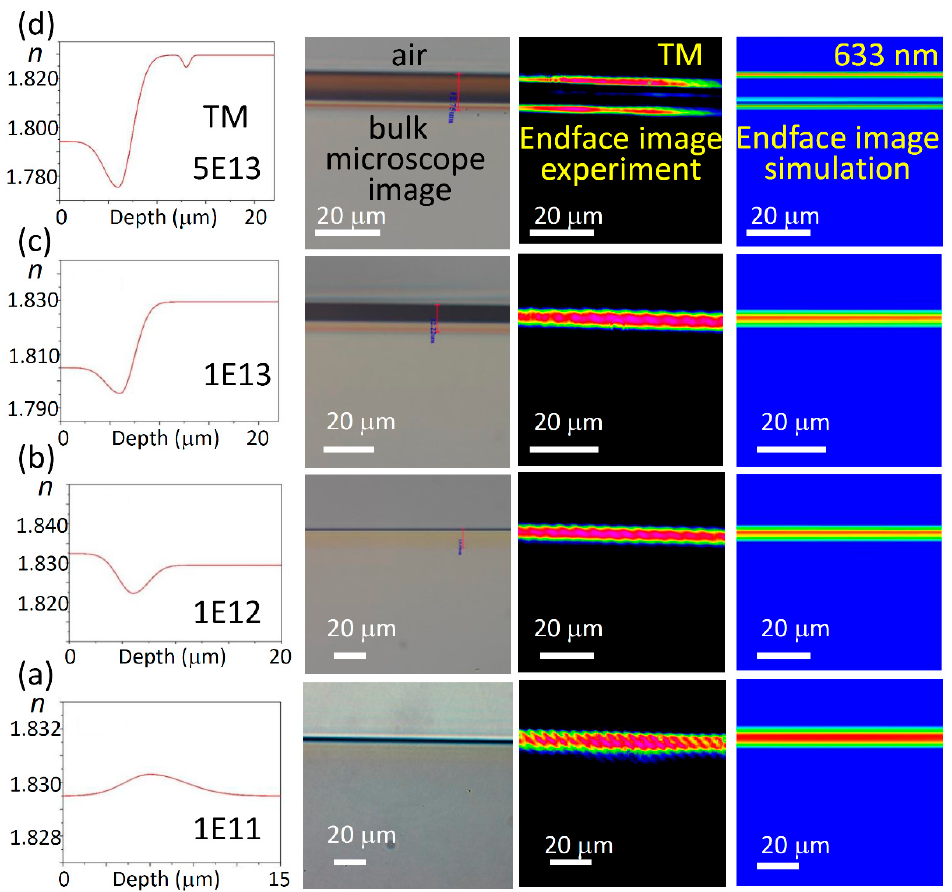
Figure 6. (Left to right) Index profiles used for the calculations of the intensity profile at the end-surfaces; optical microscopy images at the end-surface without wave guiding laser; experimental spatial intensity profiles of the wave guiding laser at the end-surface; and corresponding calculation results, for four different ion fluences ( a ) 1 × 10 11 , ( b ) 1 × 10 12 , ( c ) 1 × 10 13 , and ( d ) 5 × 10 13 ions/cm 2 . The spatial intensity profiles were calculated by the beam propagation method (BPM) using BeamPROP code.